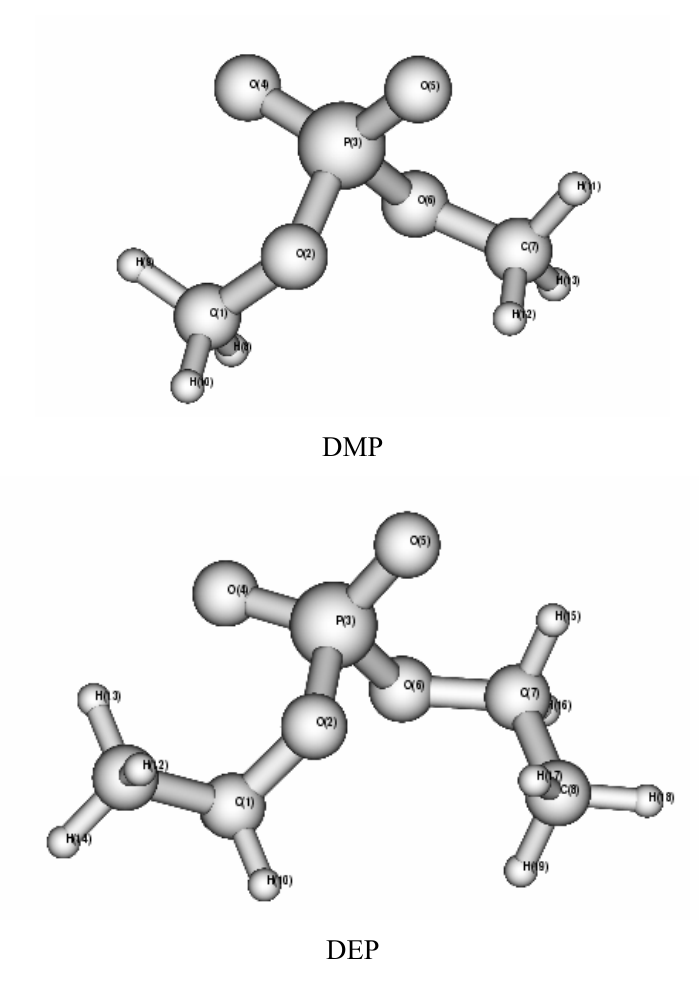
Figure 1. Structures of the DMP and DEP anions